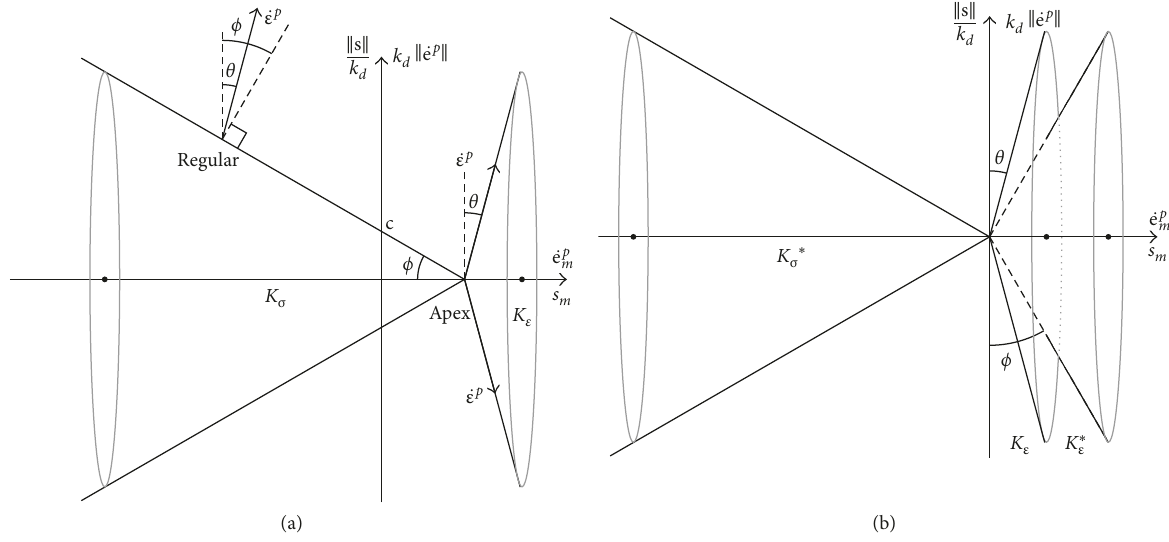
Figure 1: Cones of the nonassociated Drucker–Prager model. (a) Constitutive cones. (b) Dual